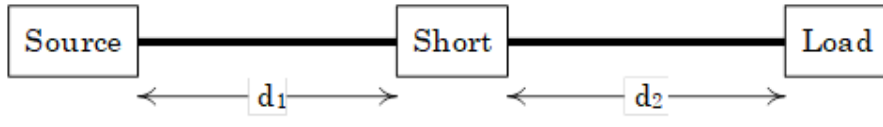
Figure A1. Transmission line with a short.